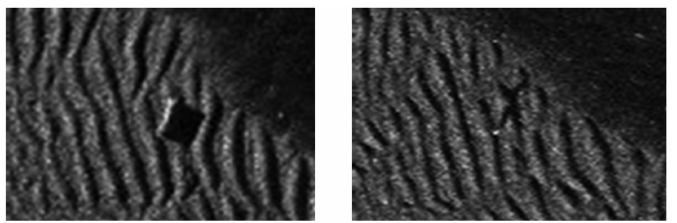
Figure 2. Actual mine observed at 85 8 (left) and at 0 8